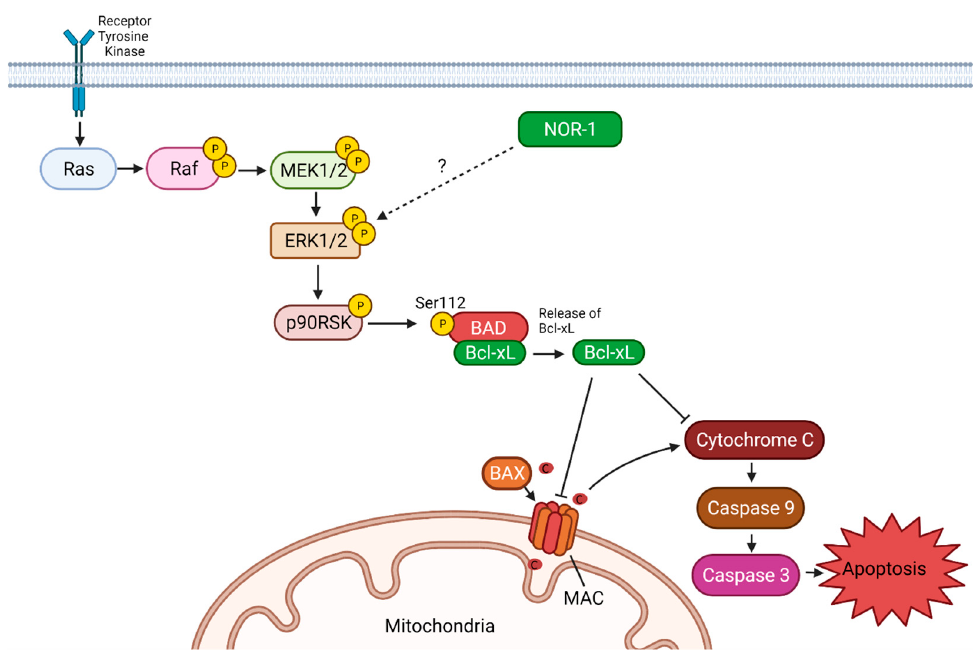
Figure 7. Proposed protective mechanism of NOR-1 overexpression in DOX-treated AC16 cardiomyocytes (CMs). Neuron- derived orphan receptor 1 (NOR-1) overexpression in DOX-treated AC16 CMs led to increased phosphorylation of extra- cellular signal-regulated kinase 1/2 (ERK1/2). The interaction between NOR-1 and ERK1/2 is currently unknown. ERK1/2 can, through p90 ribosomal S6 kinase (RSK), increase the amount of B cell lymphoma-extra-large (Bcl-xL) [21–56]. Bcl-xl inhibits cytochrome c release from the mitochondria by preventing the formation of the mitochondrial apoptosis-induced channel (MAC) and inhibiting cytochrome c in the cytosol [42]. In the end, this results in decreased caspase-3 activity and less apoptosis. Bax, Bcl-2-associated protein X; Bad, Bcl-2-associated death promoter; Ras, rat sarcoma; Raf, rapidly accel- erated fibrosarcoma; MEK1/2, Mitogen-activated protein kinase kinase 1/2; Created at 12 May 2021 with BioRender.com.